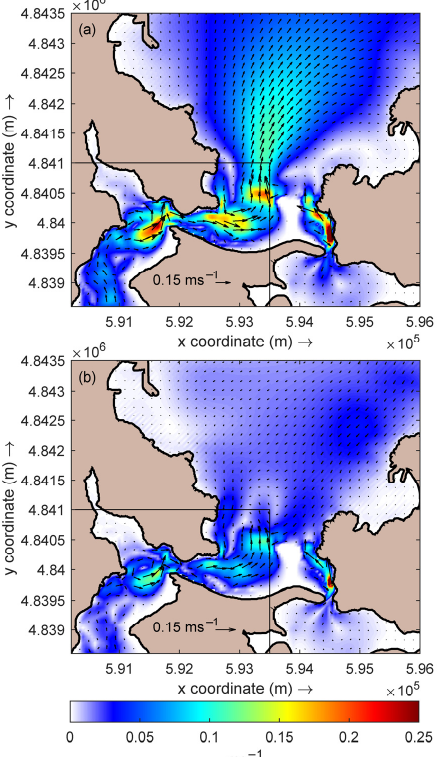
Figure 5. Residual flow pattern in Ria de Ortigueira under case study CS2 conditions. ( a ) Surface layer; ( b ) bottom layer.